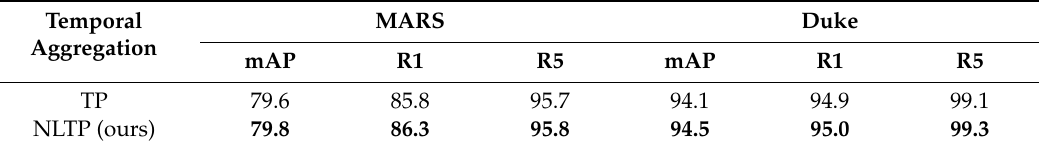
Table 5. Di ff erent time feature extraction methods NLTP and TP are compared on the MARS and